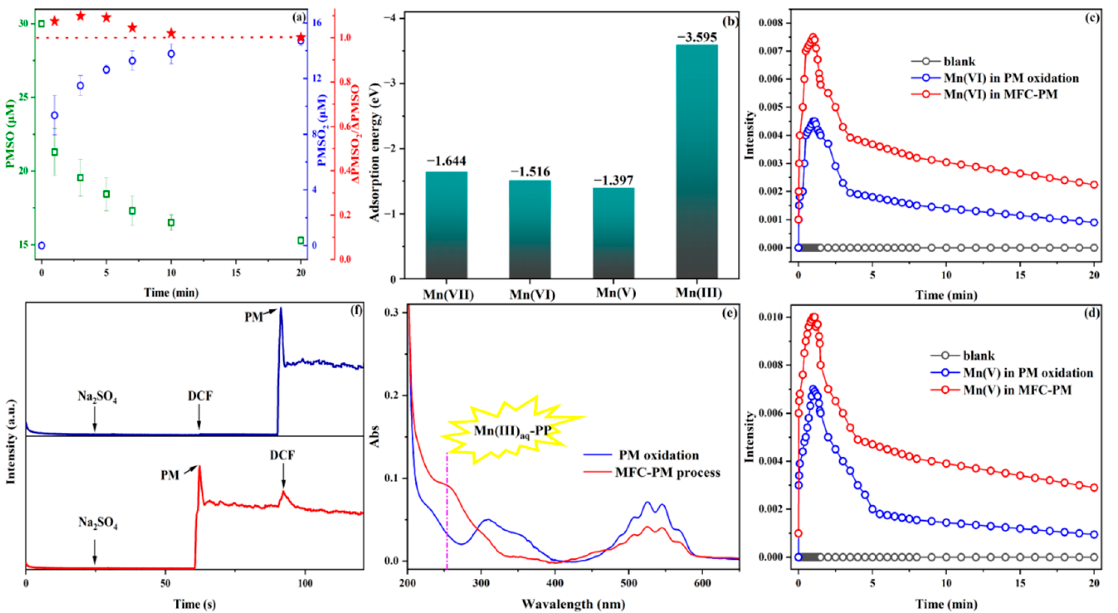
Figure 5. PMSO degradation and PMSO 2 formation in the MFC-PM process ( a ), adsorption energies of different RMnS on Pt(111) lattice plane ( b ), Mn( Ⅴ ) aq ( c ) and Mn( Ⅵ ) aq levels in the various processes ( d ), UV-vis spectra of Mn( Ⅲ ) aq -PP in the PM and MFC-PM processes after 20 min ( e ), and chronoamperometry in 0.05 M Na 2 SO 4 electrolyte ( f ).